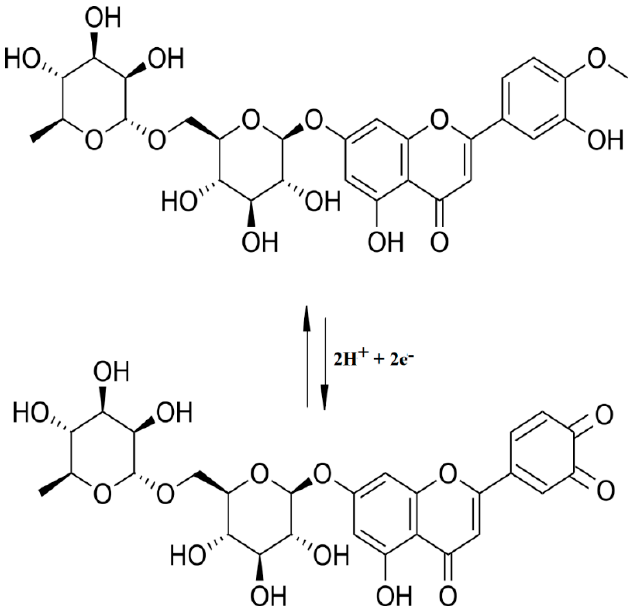
Figure 4. Cyclic voltammograms of SPCE ( a ) or PB/SPCE ( b ) immersed in a double solution 10 − 4 M diosmin/KCl 10 − 1 M, recorded with various scan rates in the range 0.1–1.0 V·s − 1 . The dependence between the values of the current of the anodic peak and the scan rate for SPCE ( c ) and PB/SPCE ( d